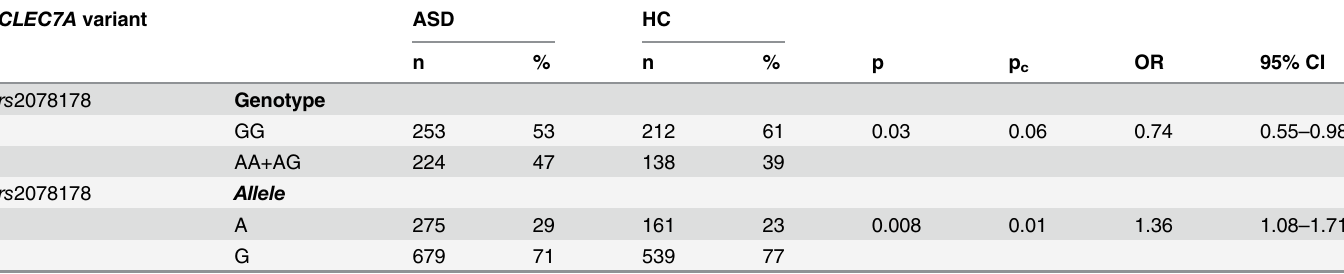
Table 2. CLEC7A genotype and allele frequencies among patients and controls. CLEC7A